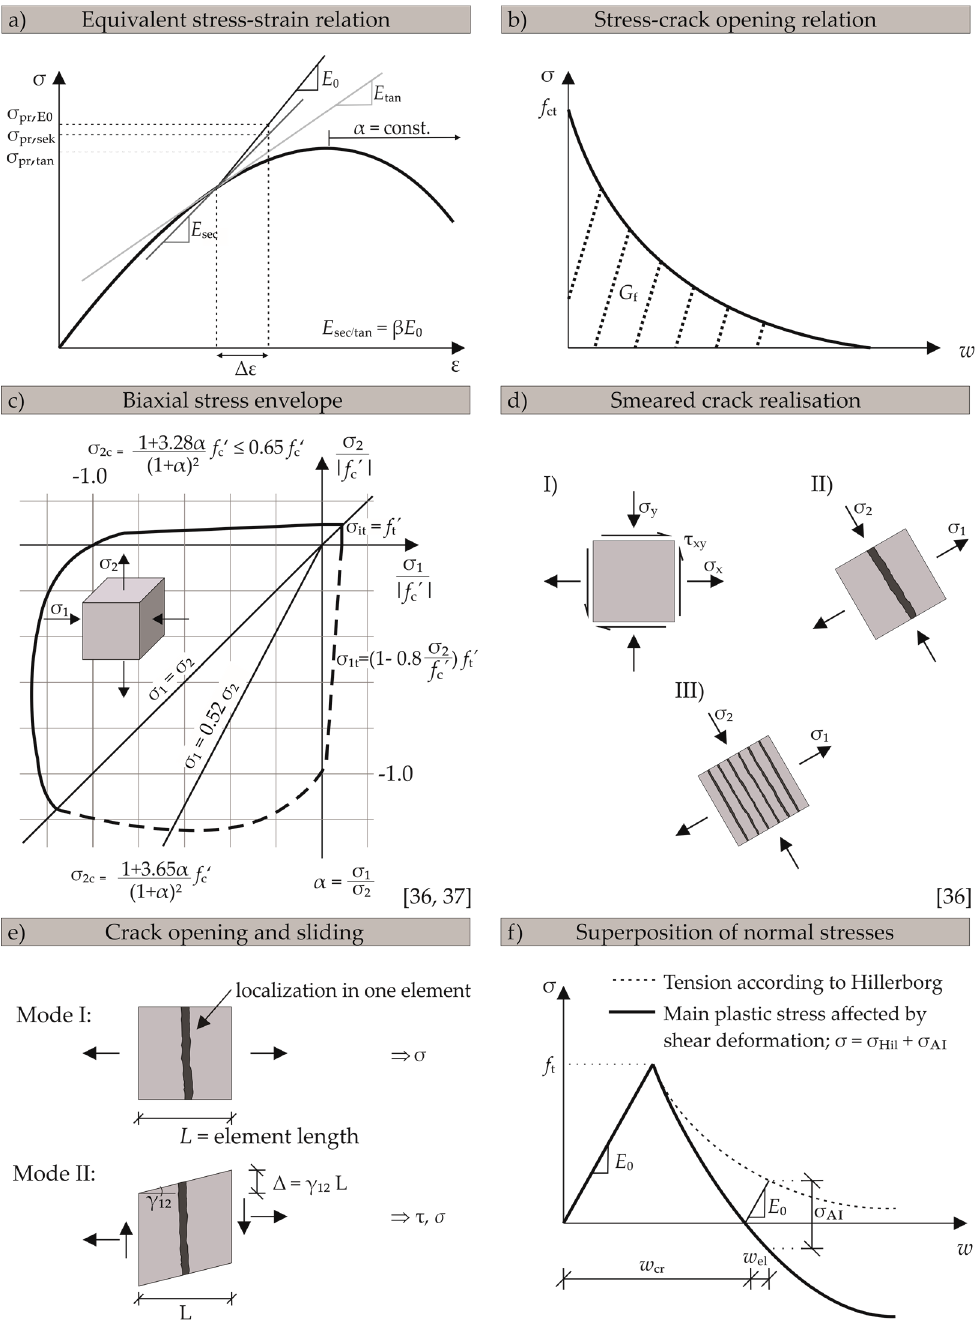
Figure 5. Theoretical background of fictitious rough crack model (FRCM) implementation in UMAT, ( a ) equivalent stress-strain relation, ( b ) typical stress-crack opening relation, ( c ) biaxial strength envelope according to Darwin and Pecknold [36,37], ( d ) smeared crack idealisation according to Darwin and Pecknold [36], ( e ) definition of crack width and shear deformation and ( f ) superposition of normal stresses in the crack.